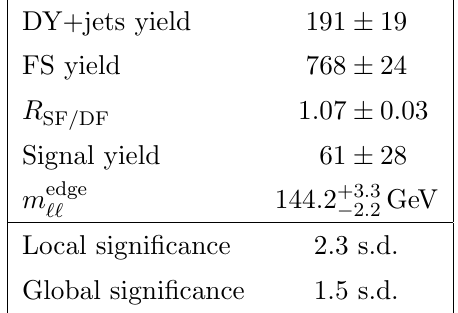
Table 5 . Results of the unbinned maximum likelihood (cid:12)t for event yields in the edge (cid:12)t SR of table 1, including the DY+jets and FS background components, along with the (cid:12)tted signal contri- bution and edge position. The (cid:12)tted value for R and the local and global signal signi(cid:12)cances SF/DF in terms of standard deviations are also given. The uncertainties account for both statistical and systematic